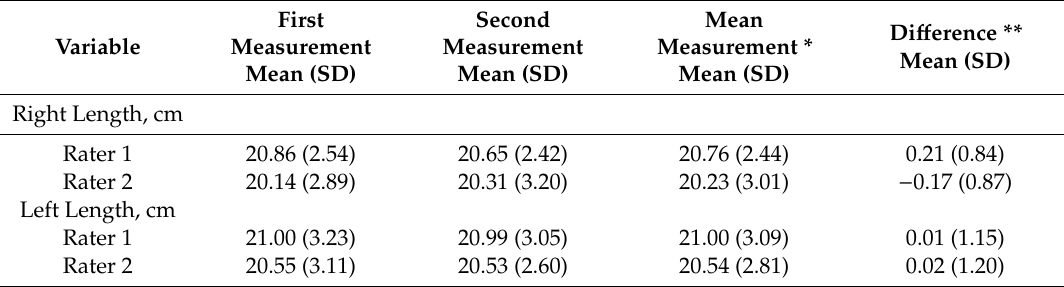
Table 2. Descriptive statistics of lower trapezius muscle